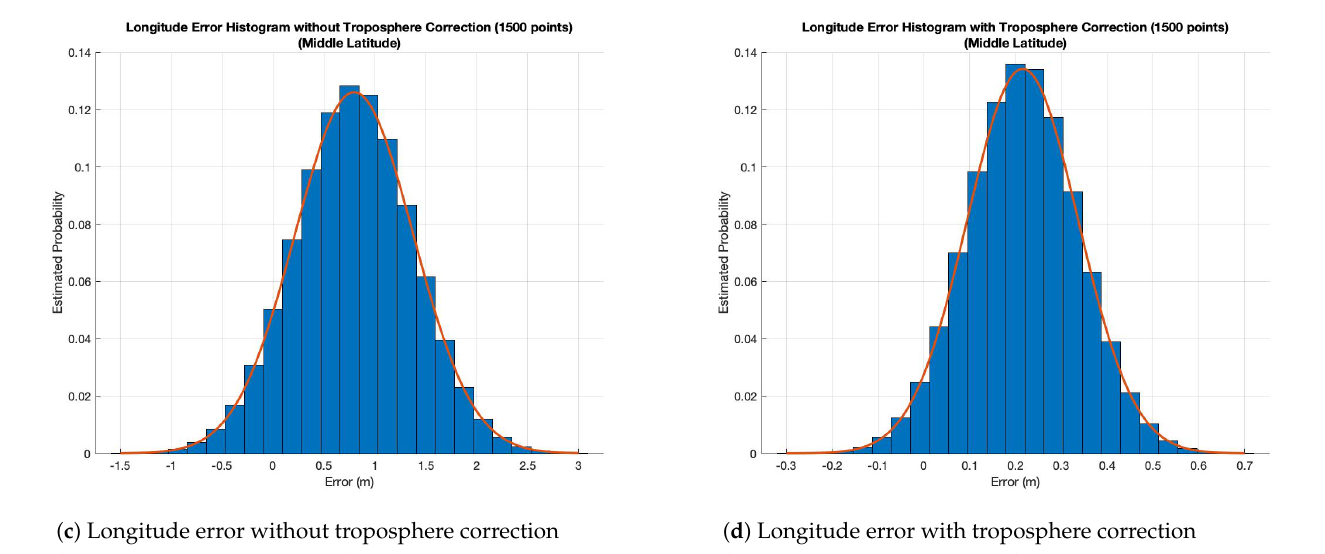
Figure 10. Histograms of experimental results on Middle